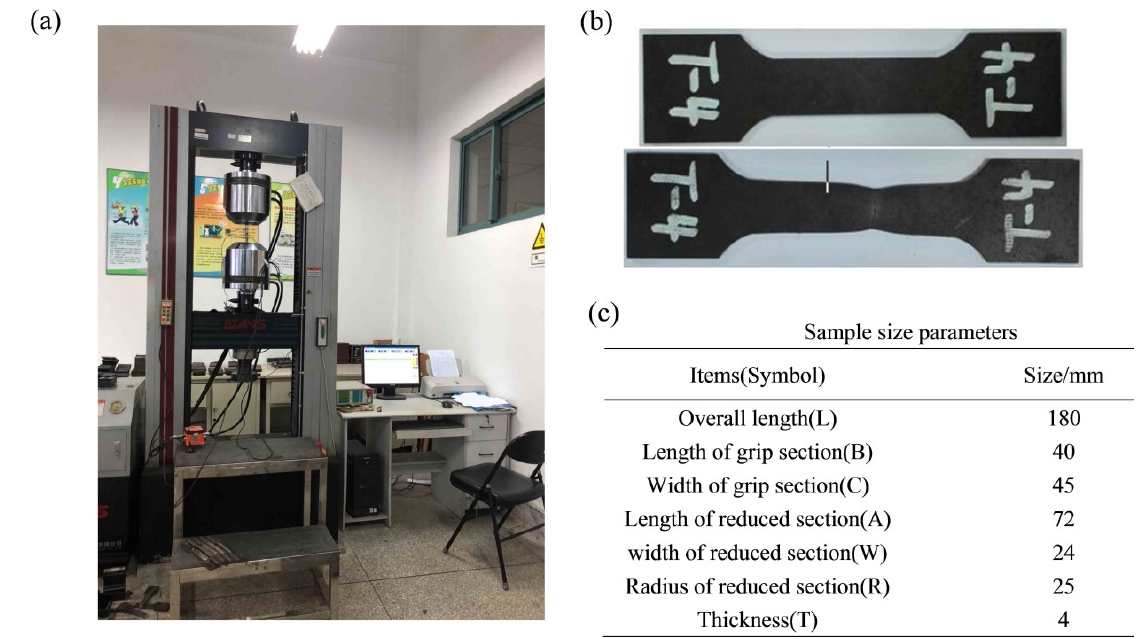
Figure 1. Quasi-static tensile test: ( a ) Test device; ( b ) Test specimen; ( c ) Dimensions of the test specimen.